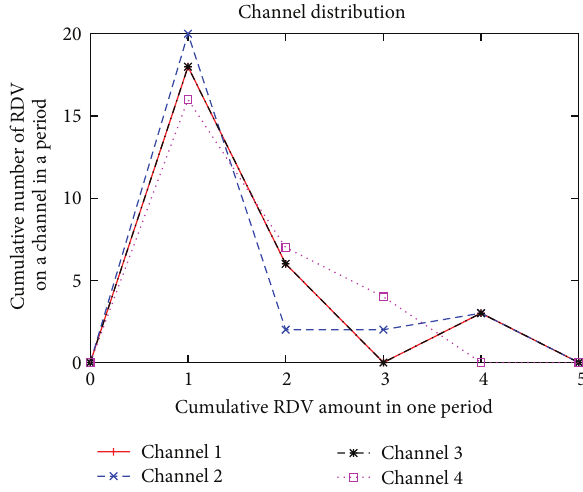
Figure 8: Symmetric channel set: Map 4 Chs (28 slots).